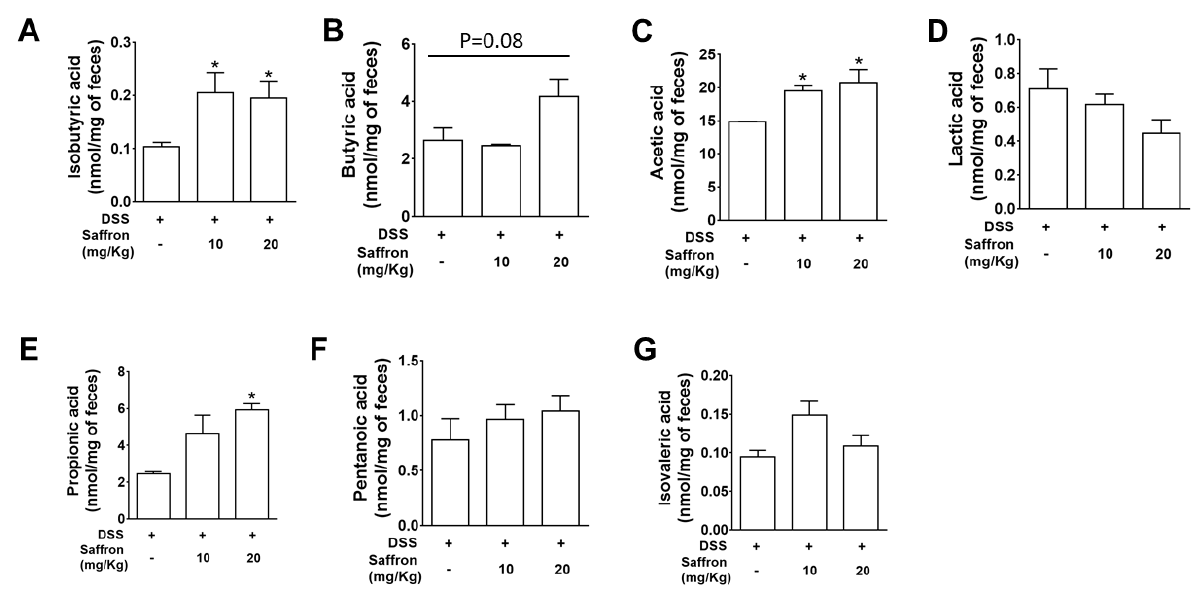
Figure 4. Saffron prevented depletion of the SCFA concentrations in fecal samples of DSS-treated mice. Fecal samples of mice were analyzed for determining the concentration of ( A ) isobutyric acid, ( B ) butyric acid, ( C ) acetic acid, ( D ) lactic acid, ( E ) propionic acid, ( F ) pentanoic acid, and ( G ) isovaleric acid. Data represent the mean ± SEM ( n = 4/group). * p < 0.05, compared to the vehicle-treated mice fecal sample.